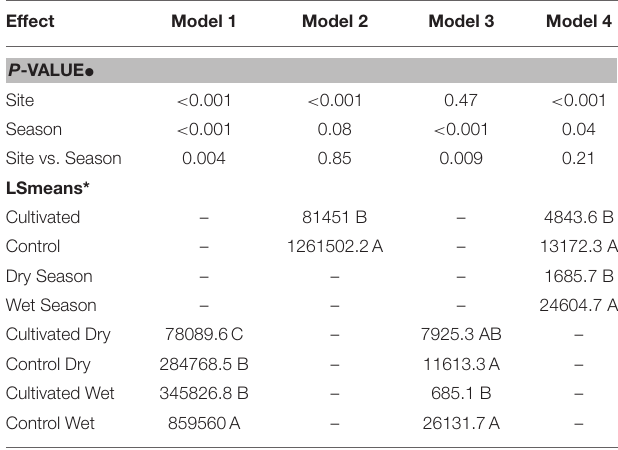
TABLE 2 | The effect of site and season on N 2 O flux in field and lab